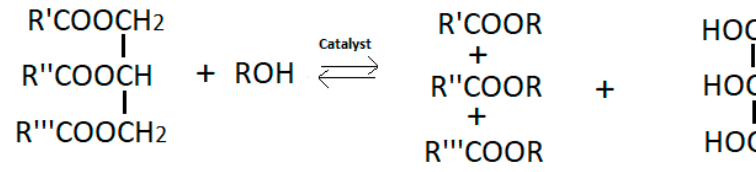
Figure 1. Transesterification reaction scheme.